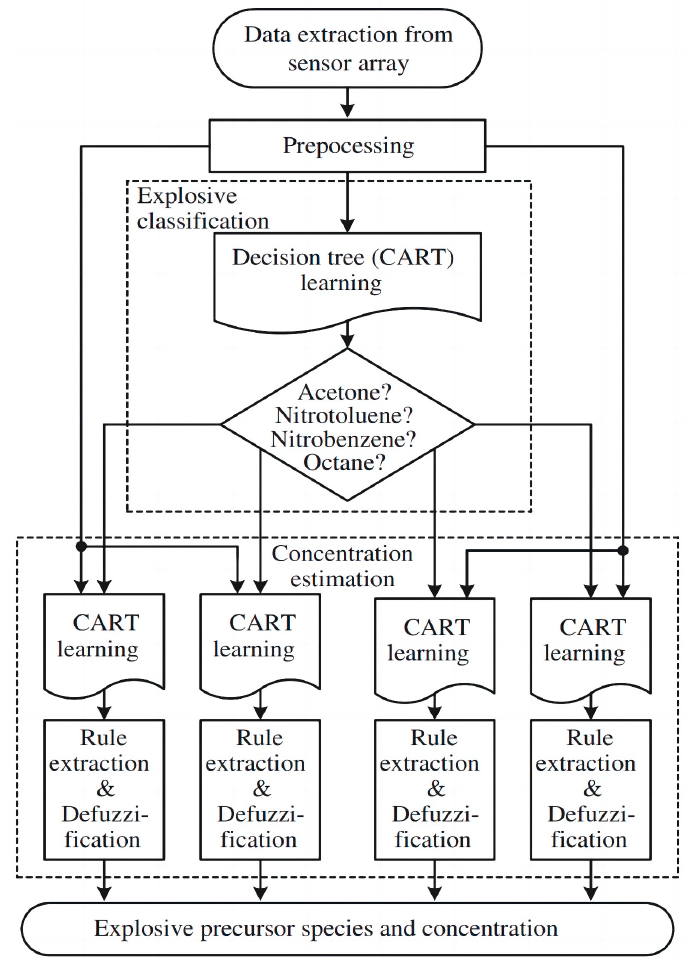
Figure 7. Flow diagram for classification and concentration estimation of explosive precursors. Re-